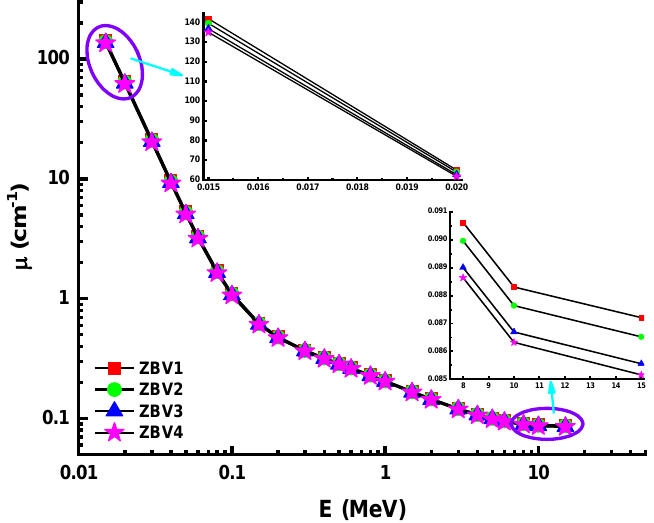
Figure 3. Variation of linear-attenuation coefficient ( µ ) against photon energy for all glasses.